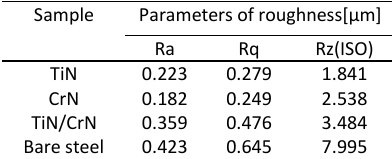
Table 2. Parameters of roughness for the examined